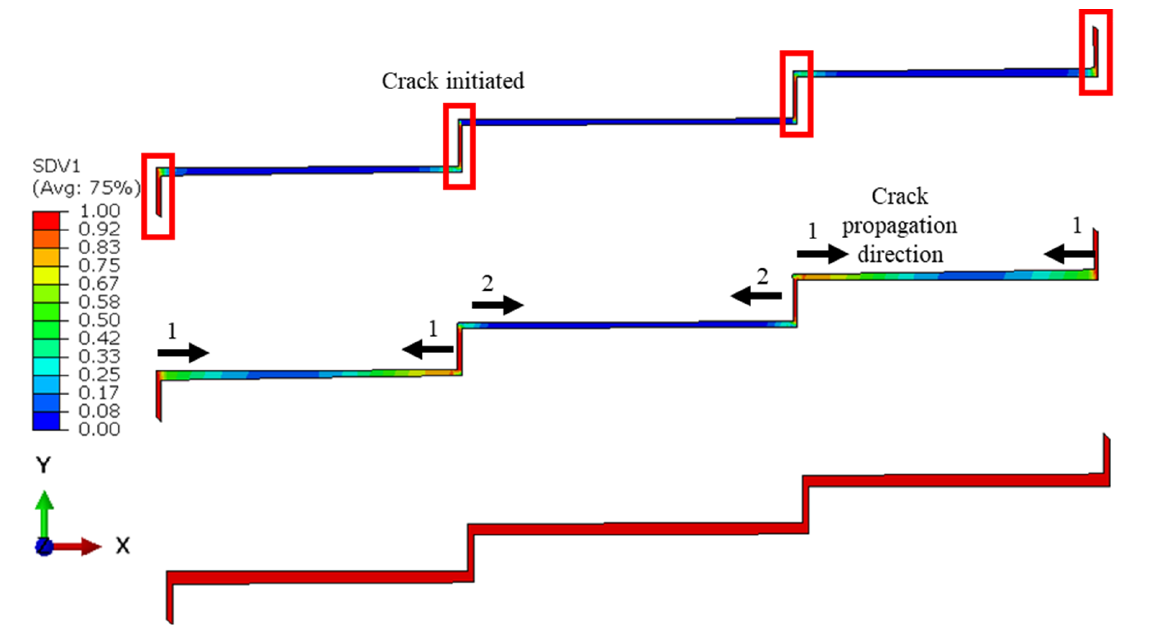
Figure 5. Distribution of the fatigue damage in the adhesive layer with the crack propagation direction and its sequence for the three-step-lap joint subjected to 8 kN tensile loading at N f /3 ( top ), 2 N f /3 ( middle ), and when the complete damage occurred at all of the points of the adhesive layer ( bottom ). Numbers 1 and 2 in the figure represent the sequence of the crack propagation.